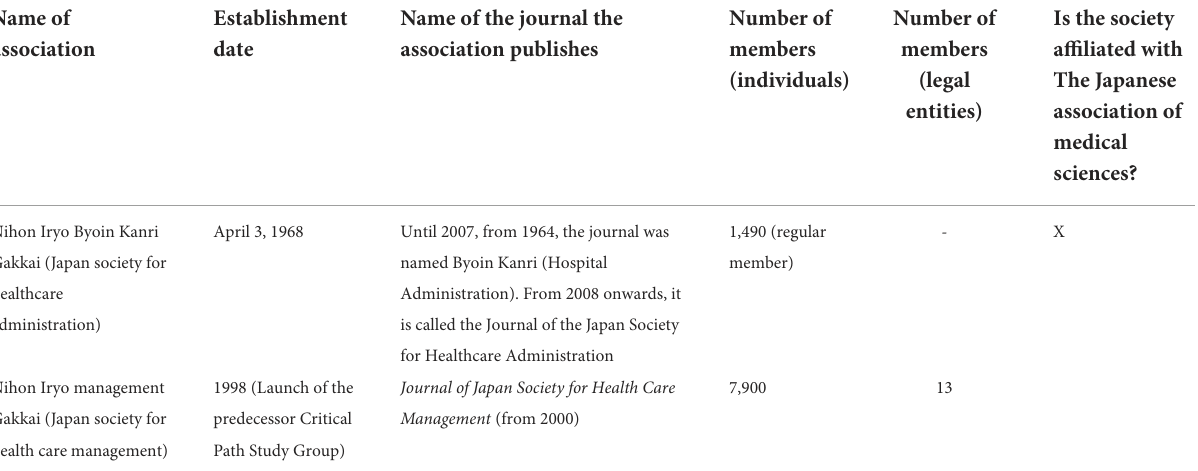
TABLE 1 Academic associations concerned with healthcare administration studies in